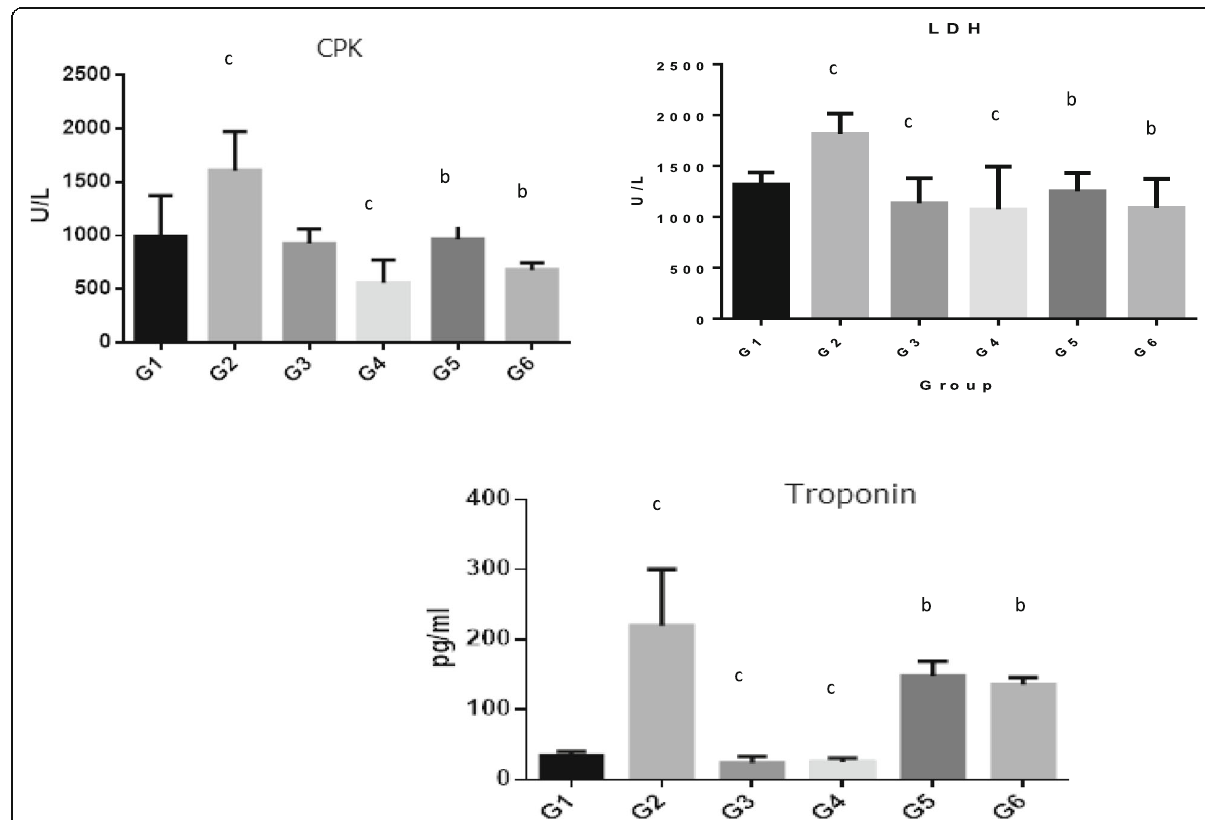
Fig. 1 Effect of extract M. verticillata on the Creatine phosphate kinase (CK), lactate dehydrogenase (LDH), for 6 weeks in albino rats. * Significant as compared with control at (p 0.05), Significant as compared with Doxoinduced heart damage at (p 0.05), G1: Control, G2: Dox., G3: Extract 250